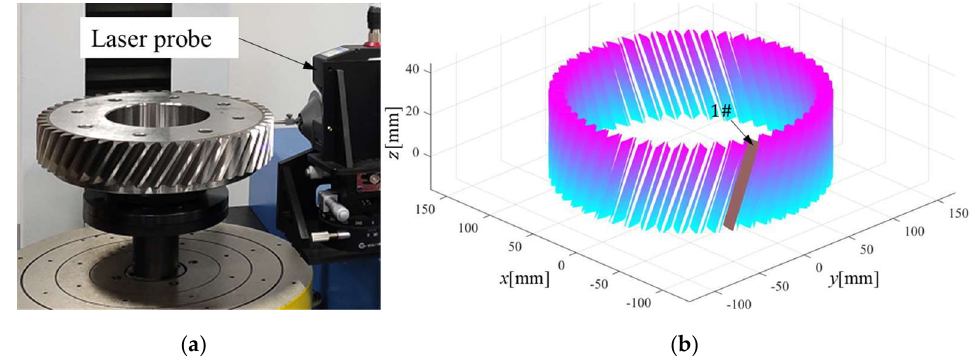
Figure 7. Gear rapid measurement center and measurement of the tested gear . ( a ) Measuring gears by gear rapid measurement center . ( b ) Tooth flank measurement data .